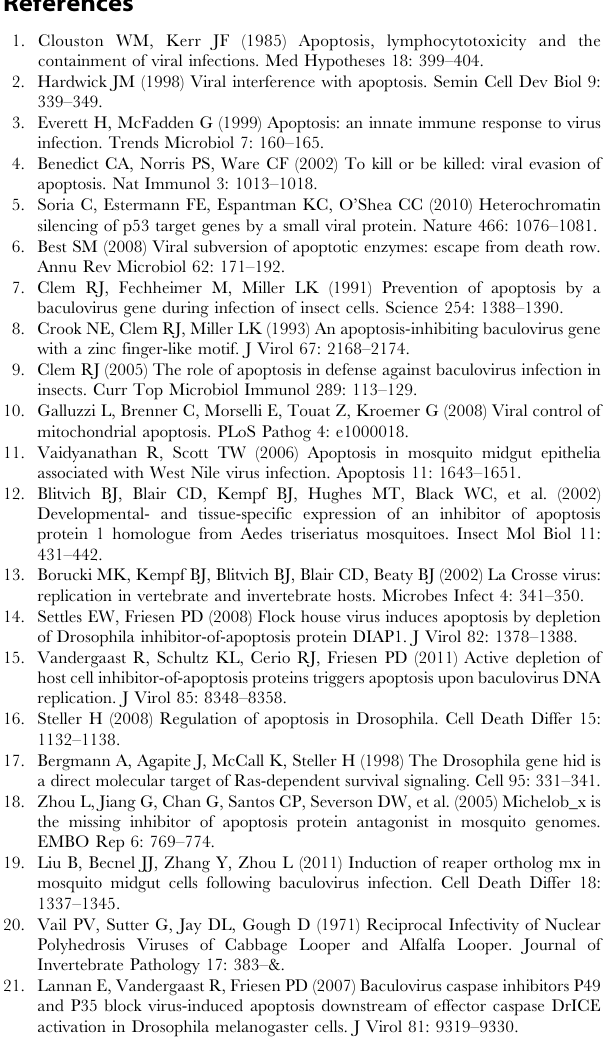
mRNA were first normalized against rp49 before calculating the ratio (AcMNPV injected/Control media injected). Figure S3 Standard curve for estimating FHV genome copy number. Known amounts of gradient-purified FHV particles were mixed with 1 adult fly and processed immediately for RNA extraction. Q-PCR was performed for RNA1 and RNA2 and the relative CT to rp49 was calculated and plotted against input viral RNA. This information was used to determine viral genome copy number in figure